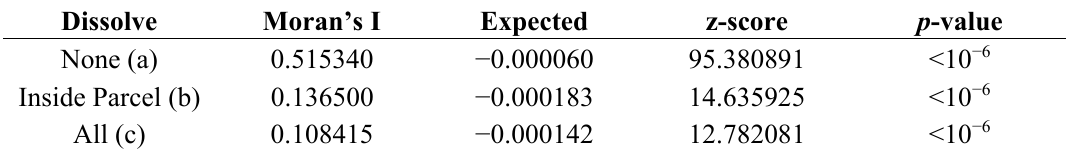
Table 2. Moran Test results.